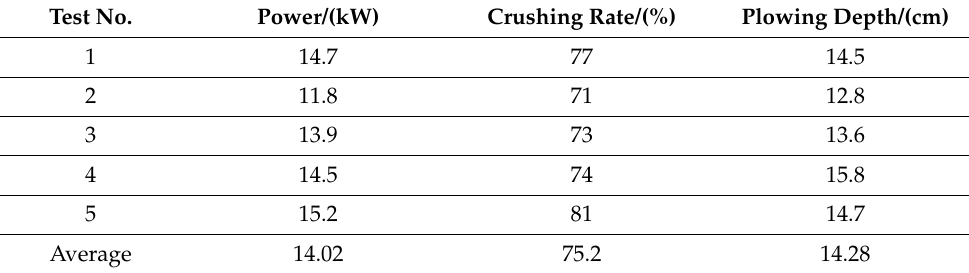
Table 7. Experiment B measurement